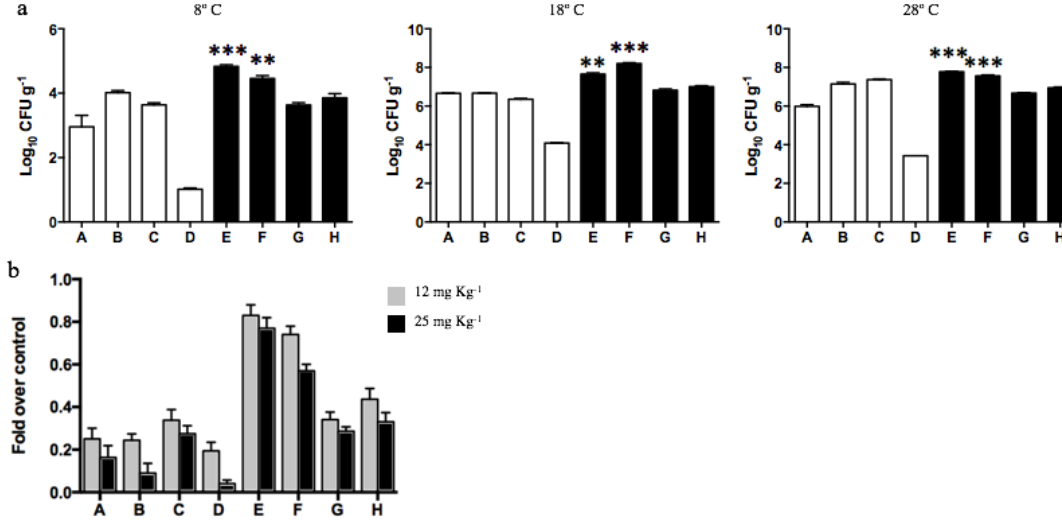
Figure 5. Bacterial counts (CFU g-1) determined in Antarctic soil samples. ( a ) Log10 CFU g-1 were determined in soils non-exposed to diesel (white bars; A, B, C, and D) and exposed to diesel (black bars; E, F, G, and H). The assay was performed at 8, 18, and 28 °C. ** and *** represents significance with a p < 0.001 and p < 0.0001, respectively. ( b ) Effect of cadmium over CFUs g-1 present on soils was analyzed in vitro at 28 °C in presence of 12 (gray bars) and 25 mg kg-1 of cadmium (black bars).